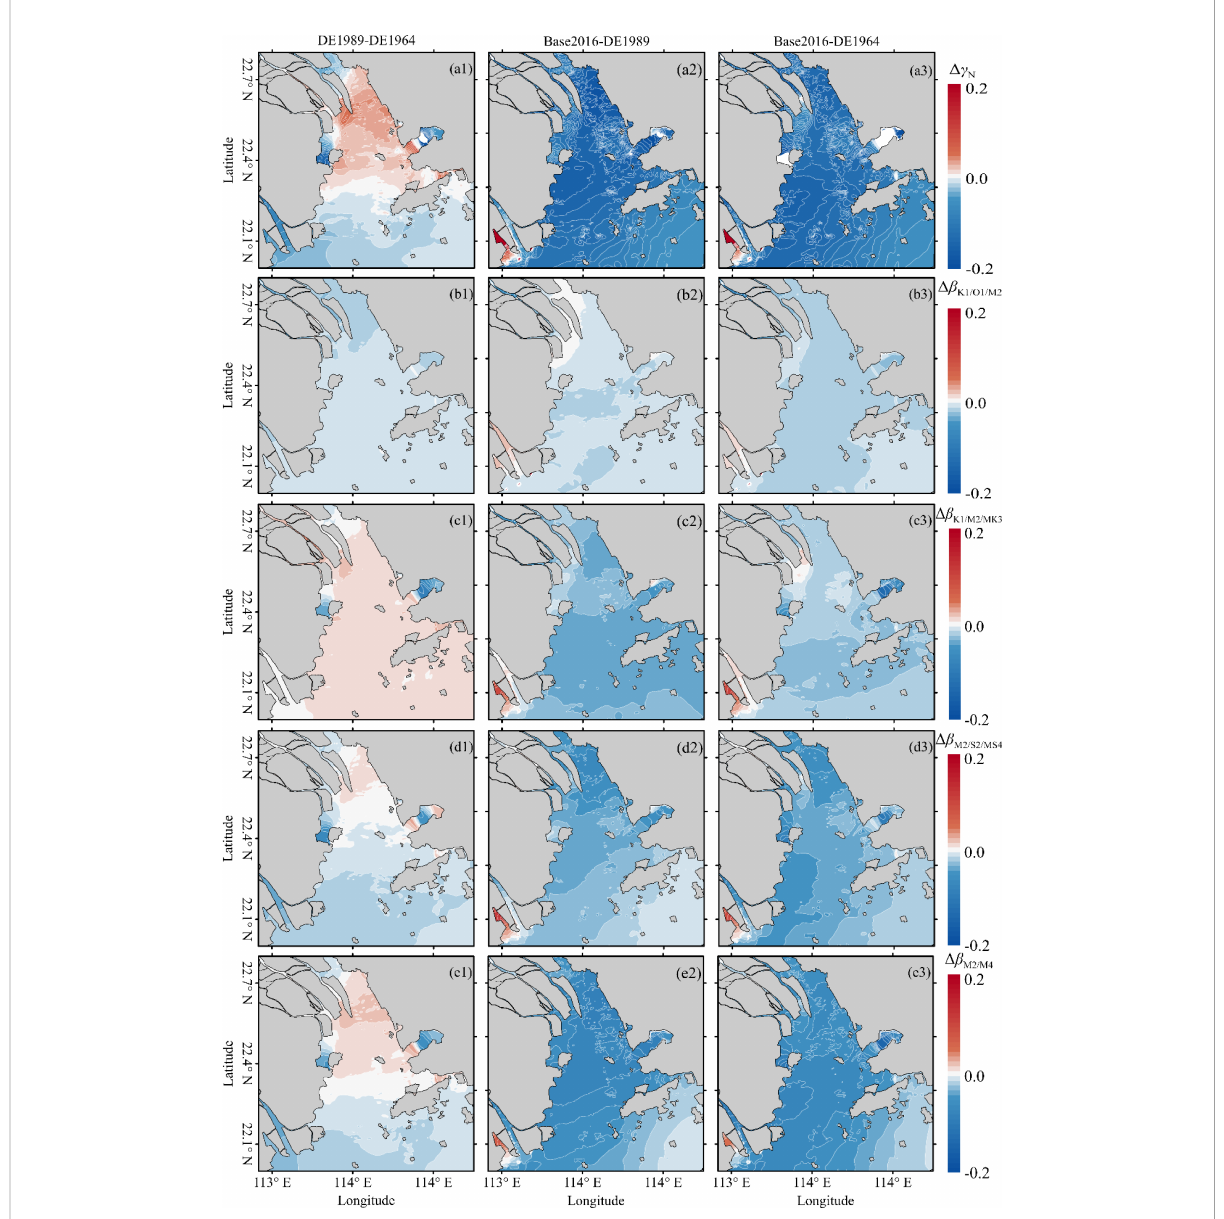
FIGURE 9 Contour map of the variations of the tidal skewness and its primary contributors owing to bathymetric alterations, including the total tidal skewness g N (A1 – A3) b K 1/ O 1/ M 2 (B1 – B3) , b K 1/ M 2/ MK 3 (C1 – C3) , b M 2/ S 2/ MS 4 (D1 – D3) , and b M 2/ M 4 (E1 – E3) . Number 1, 2, 3 represent DE1989-DE1964, Base2016-DE1989, and Base2016-DE1964,